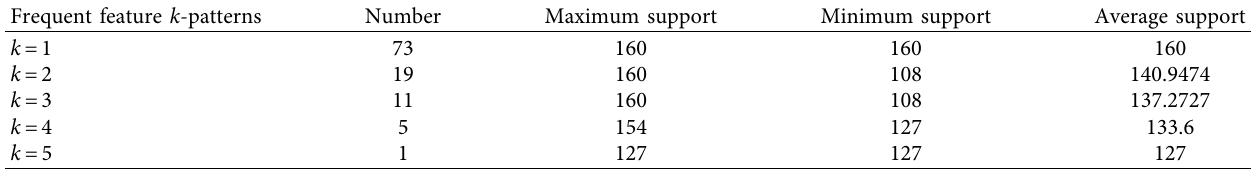
Table 5: Frequent feature pattern mining results based on the equal-density discretization coding method.